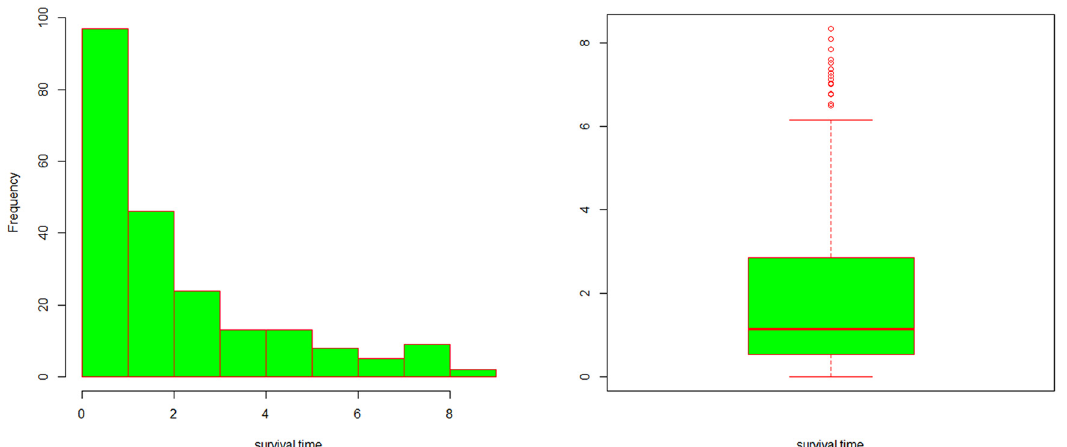
Figure 1: Histogram and box plot for the survival data.